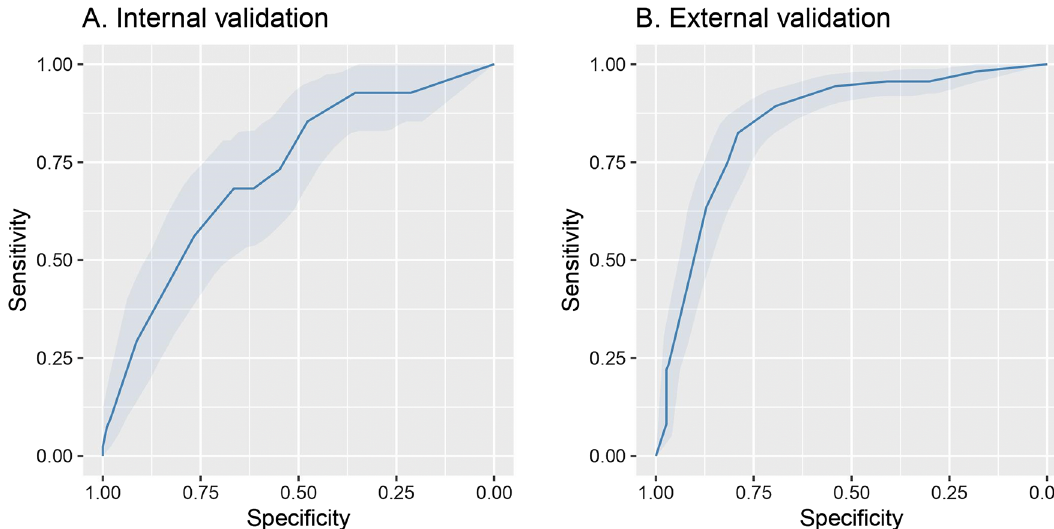
Figure 1. Receiver operator characteristics curves for mortality prediction. ( A ) The c-statistic for in-hospital mortality using Elastic net LR model had an AUC of 0.72, 95% CI: 0.64 to 0.81 in the internal validation cohort. ( B ) In the external validation cohort the model had an AUC of 0.85 (95% CI: 0.8 to 0.89) for in-hospital mortality.